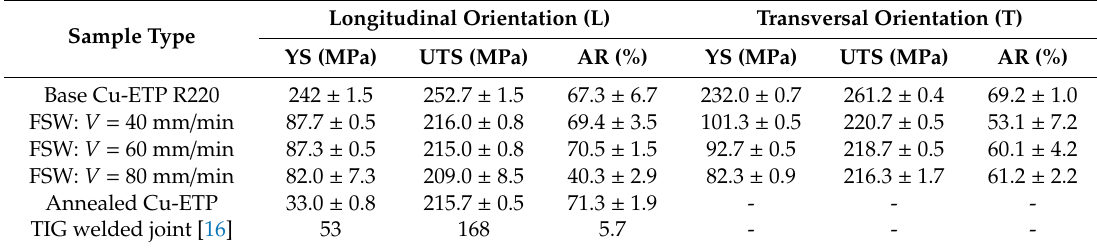
Figure 7. Tensile curves of solid samples: ( a ) base material—orientation L; ( b ) base material—orientation T, ( c ) base material—comparison of the representative curves for L and T orientation, ( d ) base material after annealing at 600 ◦ C. Table 2. Mechanical properties of tested samples.